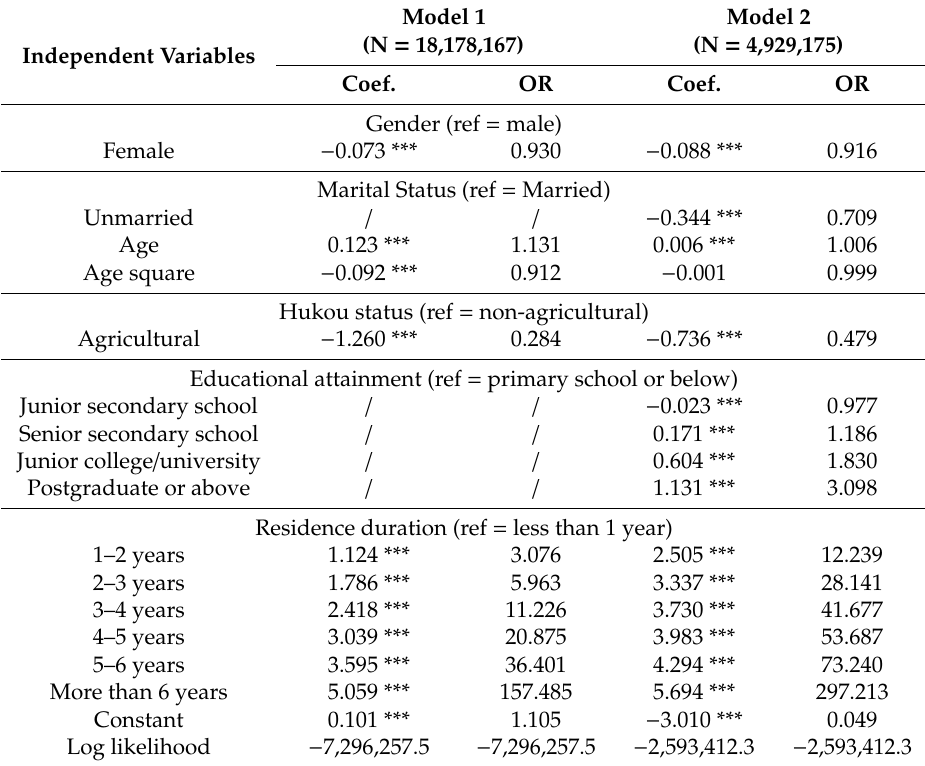
Table 4. Regression results on individual characteristics and actual urban